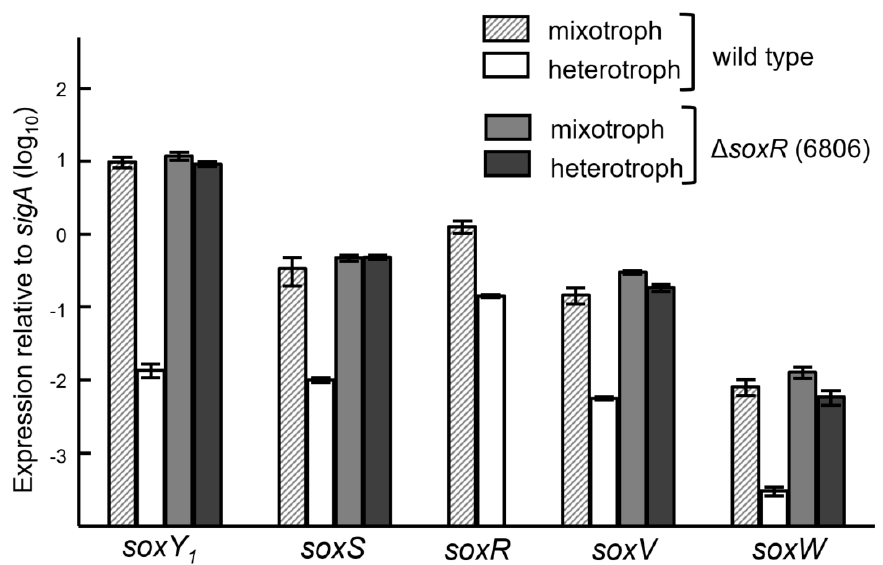
Figure 6. Expression of the soxS , soxV , soxW , and soxY 1 genes in the B. diazoefficiens wild type and in the soxR mutant 6806. Expression was measured in cells grown under heterotrophic (4 mM succinate) and mixotrophic conditions (4 mM succinate plus 4 mM thiosulfate). The expression of each gene under each condition had been normalized to that of the housekeeping sigma factor gene sigA . The column heights and error bars represent the means and standard deviations of three cultures where each culture was measured in triplicate.